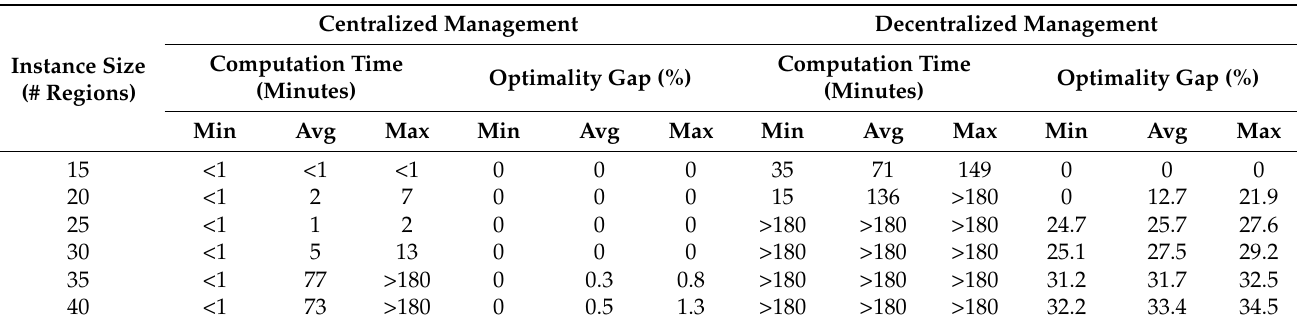
Table 11. Results of the computational